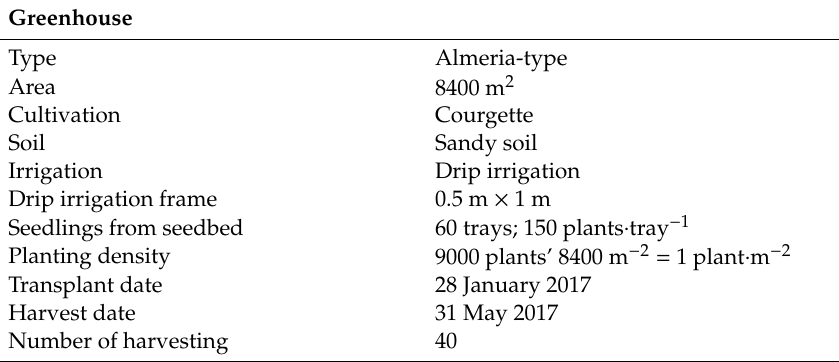
Table 1. Greenhouse